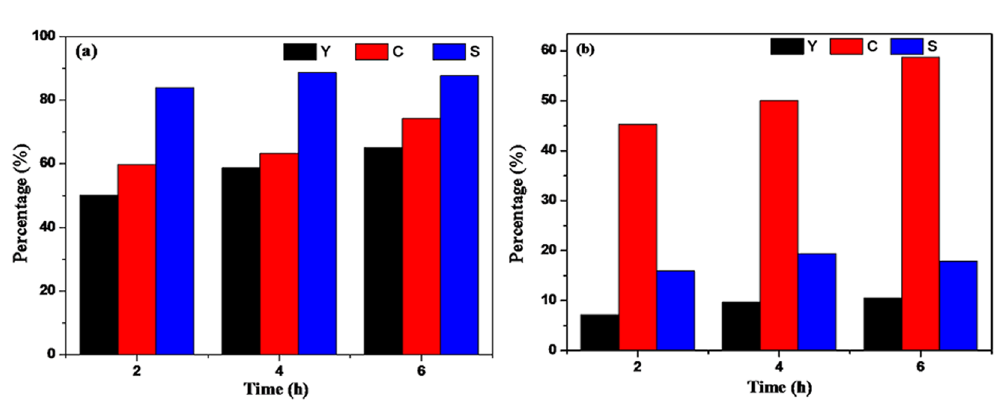
Figure 9. Typical time course of photocatalytic performance for selective oxidation of benzyl alcohol to benzaldehyde and reduction of nitrobenzene into aniline with visible light ( λ> 420 nm) with N 2 purge. benzyl alcohol ( a ), nitrobenzene ( b ) (In Figures, C, Y, and S mean Conversion, Yield, and Selectivity,